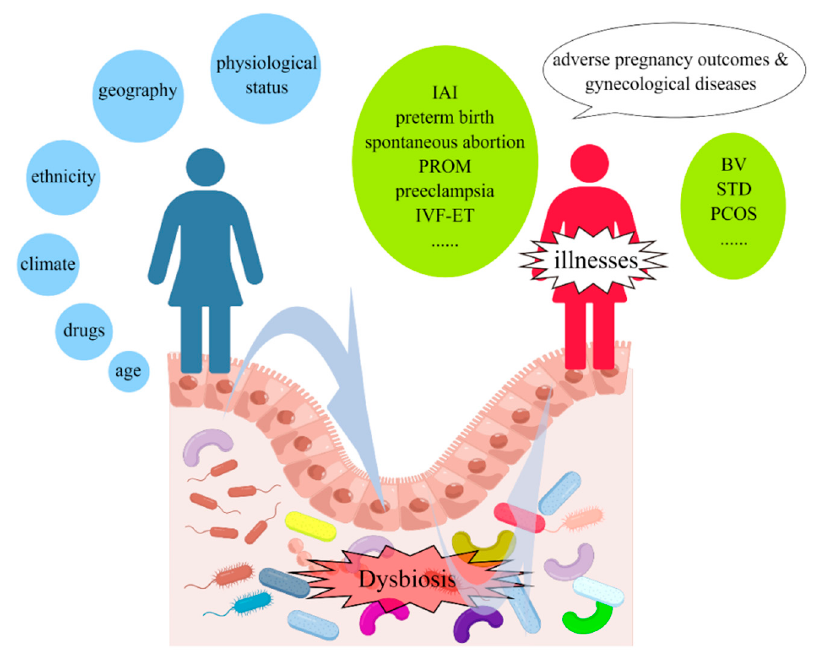
Figure 1. Dysbiosis of vaginal microbiota reciprocally impacts reproductive health. The composition of vaginal microbiota is affected by various factors, including but not limited to ethnicity, age, physiological status, drugs, geography, climate, and environmental factors. An imbalance of vaginal microbiota then leads to reproductive diseases, such as intra-amniotic infection (IAI), spontaneous preterm birth, spontaneous abortion, premature rupture of membranes (PROM), preeclampsia, in vitro fertilization and embryo transfer (IVF-ET), bacterial vaginosis (BV), sexually transmitted diseases (STD), polycystic ovary syndrome (PCOS), gynecologic malignancies.